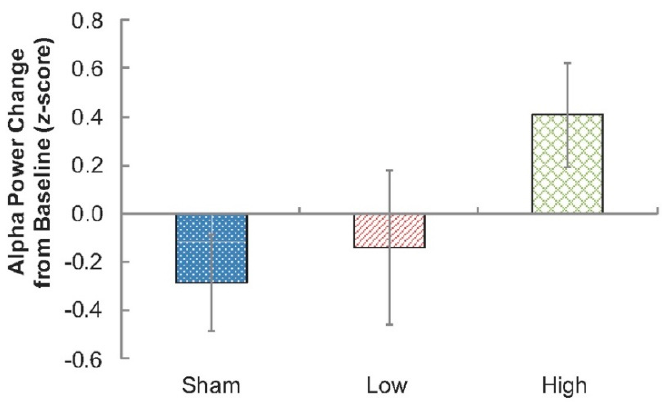
Figure 2. The change in EEG alpha power between Baseline and the end of exposure (min 22–26) in each of the Sham, Low, and High RF-EMF exposure conditions. Error bars denote standard errors of the means. Table 2. EEG alpha and finger temperature values at Baseline and end of RF-EMF exposure for the Sham, Low, and High Exposure conditions (standard errors in parentheses).